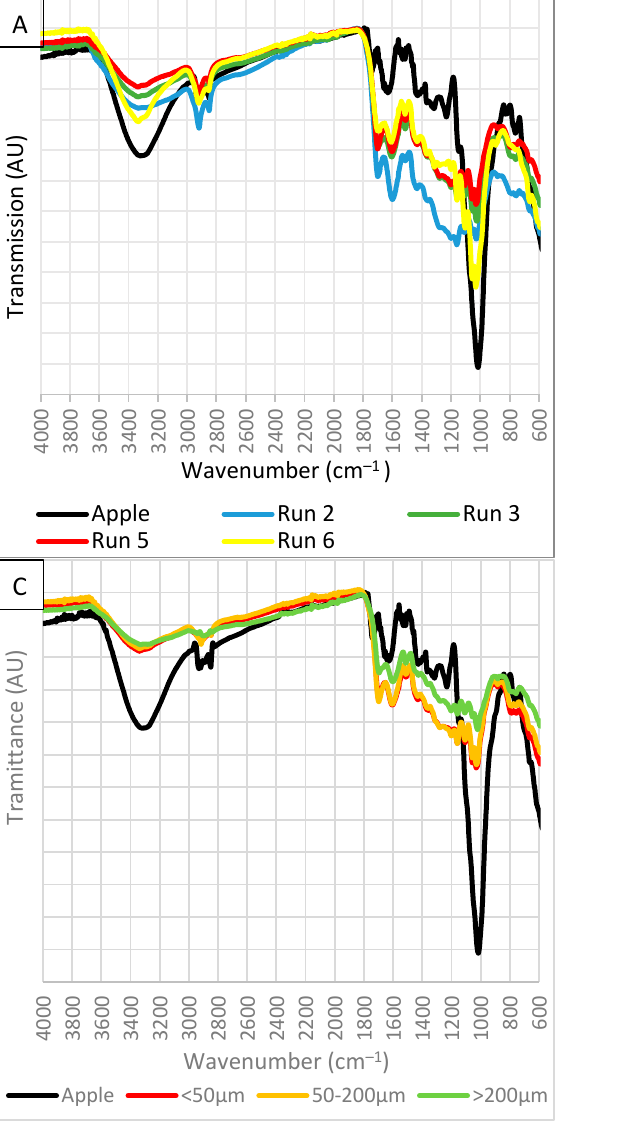
Figure 1. FTIR spectrum of ( A ) HC produced under different process temperatures, solution ratio and residence time, Run 5, Run 6, Run 2 and Run 3, respectively, ( B ) HC produced at different solution pH and washed with acetone, ( C ) HC produced using different particle size and ( D ) HC produced from different biomass feedstocks.